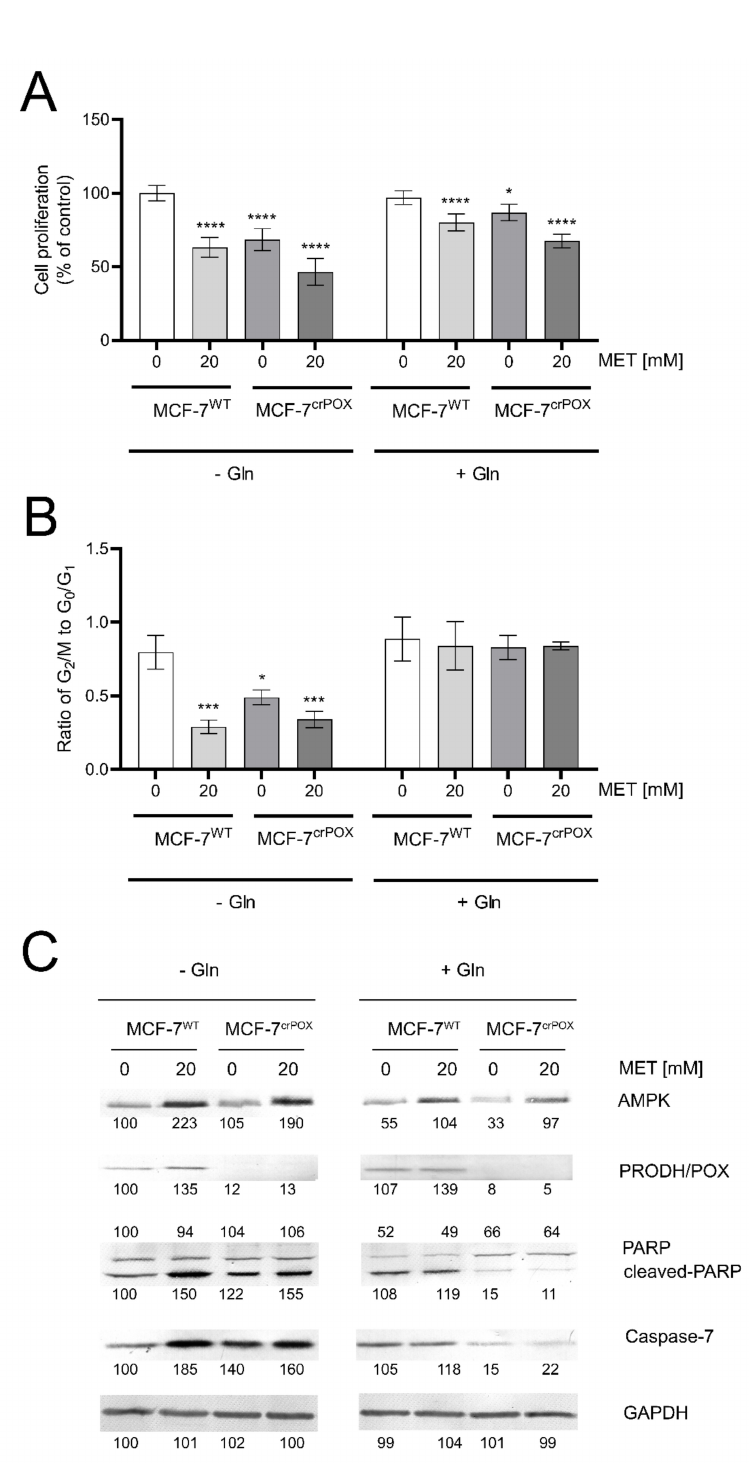
Figure 1. Cell proliferation ( A ) the ratio of cell percentage in G 2 /M to G 0 /G 1 phase. ( B ) Western blot for AMPK, PRODH/POX, PARP and caspase 7. ( C ) in metformin (MET, 20mM) treated MCF-7 WT and PRODH/POX-knock out MCF-7 crPOX cells cultured in medium with or without glutamine (Gln) for 24 h. The mean values ± standard error (SEM) from 3 experiments done in duplicates are presented at * p < 0.05, *** p < 0.001, and **** p < 0.0001. Representative Western blot images were shown. Supplementary Materials contain statistical analysis of the evaluated proteins (Figures S3–S6). The percentage of cells in G0/G1, S and G2/M phases of the cell cycle of MCF-7 WT and MCF-7 crPOX cells treated with metformin with or without Gln (Figure